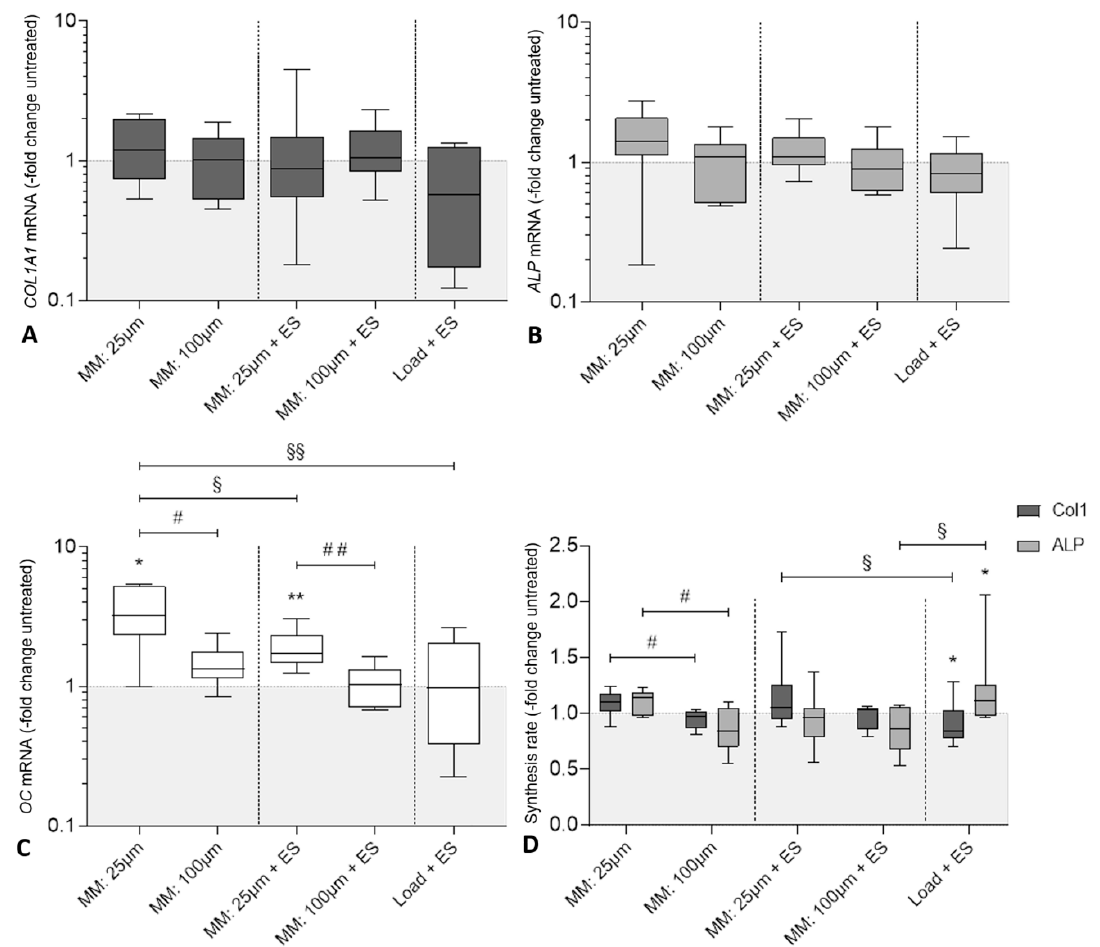
Figure 5. Evaluation of osteogenic di ff erentiation of human osteoblasts following biophysical stimulation. Relative gene expression of osteogenic markers for bone formation: ( A ) collagen type I alpha 1 chain ( COL1A1 ), ( B ) alkaline phosphatase ( ALP ), and ( C ) osteocalcin ( OC ) in human osteoblasts after treatment with micromotions and electrical stimulation (MM + ES) compared to osteoblasts treated solely with micromotions (MM) and osteoblasts treated with titanium bodies and electrical stimulation (Load + ES). Gene expression levels of COL1A1 , ALP , and OC were determined via semi-quantitative polymerase chain reaction (qPCR). Results are presented as boxplots of the percentage of 2 ( − ∆∆ Ct) related to loaded controls ( n ≥ 6). ( D ) Synthesis rates of osteogenic markers procollagen type 1 and alkaline phosphatase (ALP) in human osteoblasts. The release of type I C-terminal collagen propeptide in the cell culture supernatant was determined using ELISA and related to the total protein concentration. The ALP activity was determined colorimetrically by the hydrolysis of p-nitrophenyl phosphate. Results are presented as box plots related to the loaded controls ( n ≥ 6). * p < 0.05, ** p < 0.01 compared to the loaded controls (Wilcoxon’s signed-rank test); # p < 0.05, ## p < 0.01 comparison between di ff erent parameters (Mann–Whitney U test); § p < 0.05, §§ p < 0.01 comparison between di ff erent treatment groups (Mann–Whitney U test).